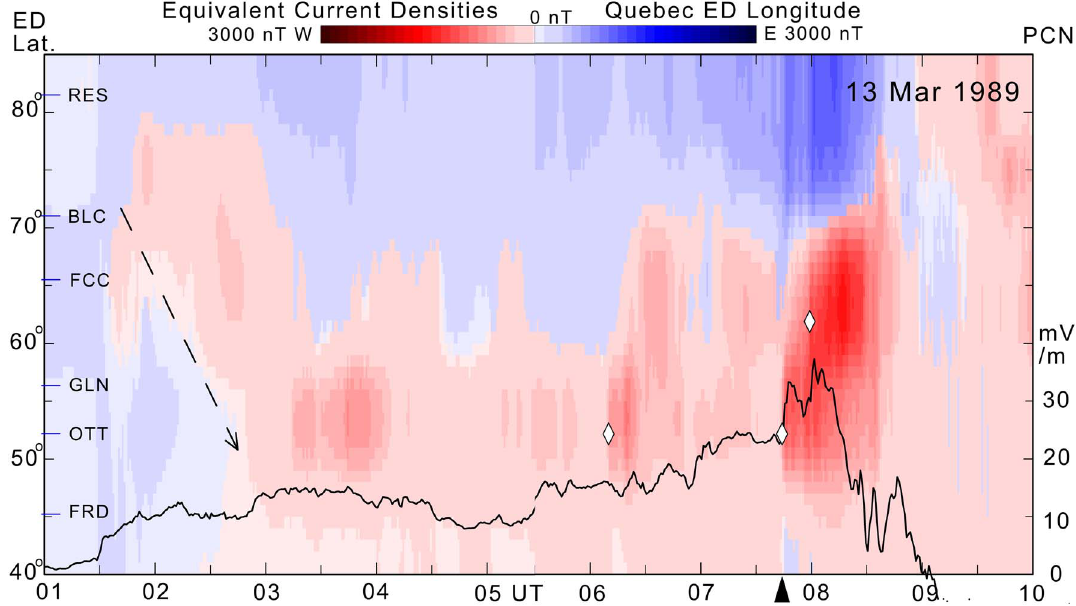
Fig. 9. Equivalent overhead current pro fi le at Quebec magnetic longitude throughout 01:00 to 10:00 UT on 13 March 1989 in the format of Figure 6. The overhead current intensity scales are the same for the two fi gures. Substorm magnetic gradients steeper than 5 nT/s (interpolated at Quebec longitude) are shown by the white diamonds. PCN index values are displayed by the solid black curve. The black triangle marks the time of power outage. Table 4. Solar wind parameters for cases of persistent strong transpolar convection (large PC indices) throughout 1981 – 2016. PCN range